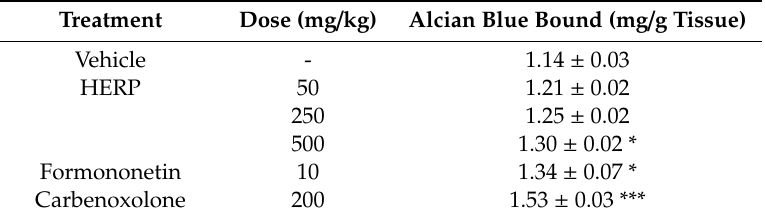
Table 4. E ff ects of intraduodenal treatments with HERP and formononetin on Alcian blue binding to free gastric mucus from pylorus ligatures in